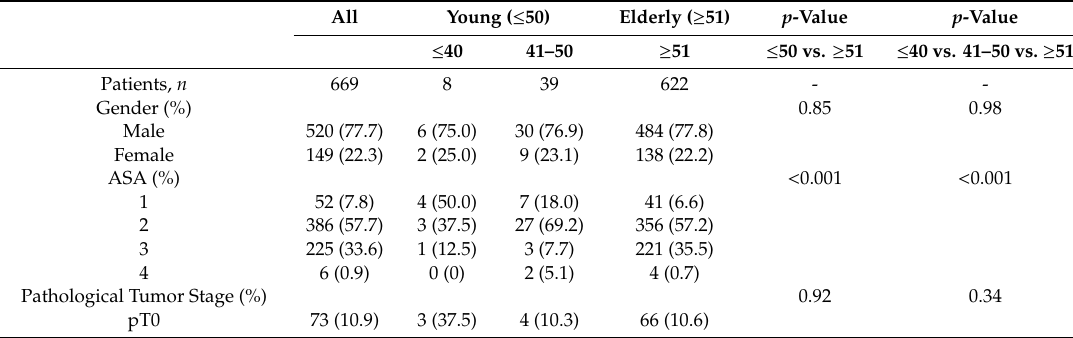
Table 1. Descriptive characteristics stratified by dichotomy age groups of 669 UCB patients treated with radical